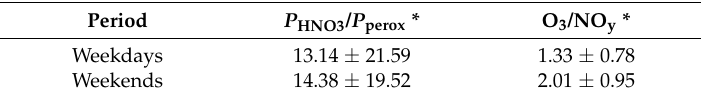
Table 7. Results of the ANOVA performed for the averages of modeled P HNO 3 / P perox ratios and O 3 /NO y ratios between 12:00 and 18:00 CDT at the OBI site during the weekdays and weekends of September 2012 and March 2013.